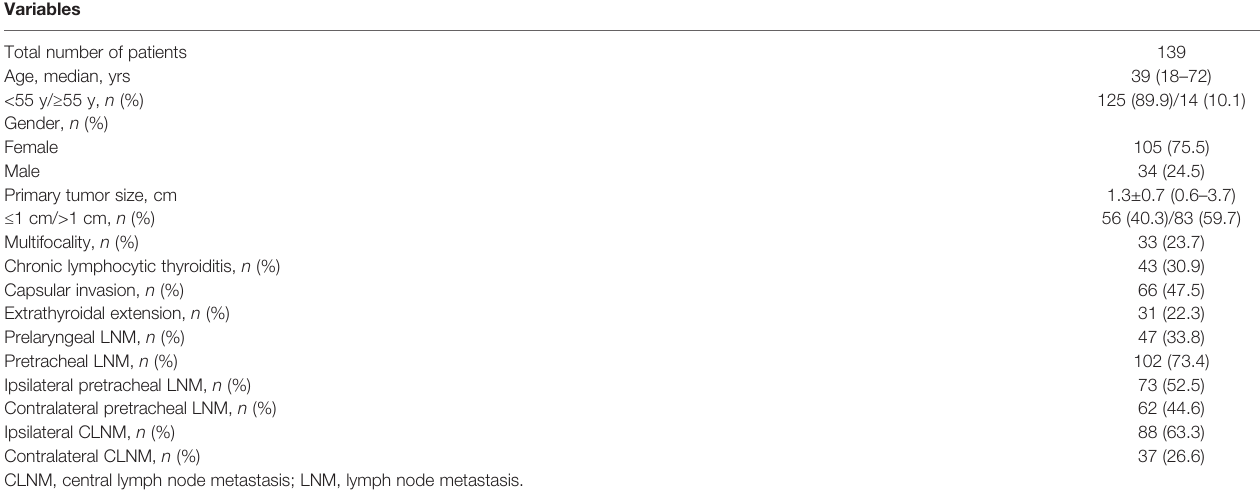
TABLE 1 | Clinicopathologic characteristics of patients.